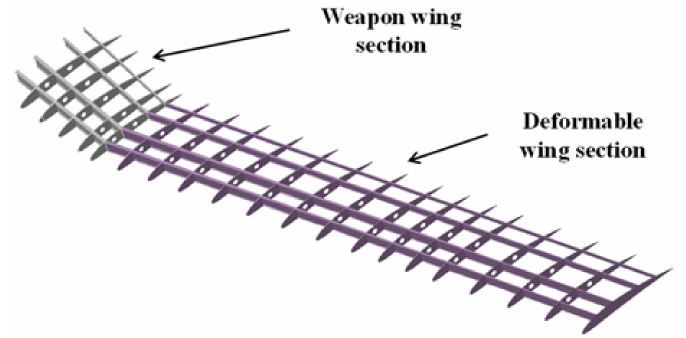
Figure 4. Shape and structure of multi-section variable-sweep wing. The gray part is the weapon section, and the purple part is the deformable section. Table 3. Positions and dimensions of wing